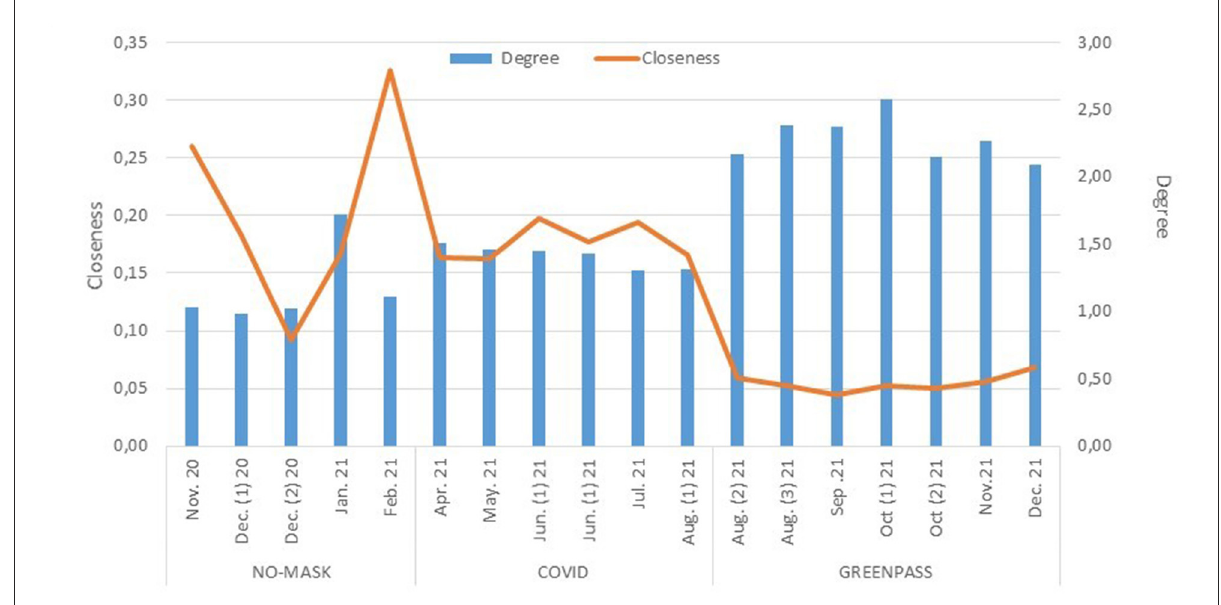
FIGURE5 Distribution of degree and closeness . Time series: November 2022–December 2121.